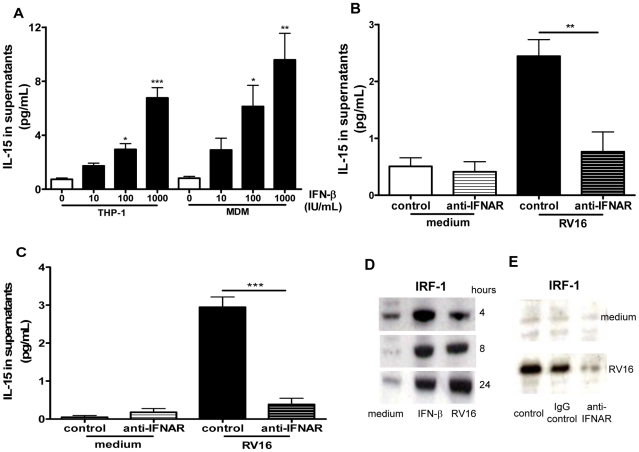
IFN-β induces IL-15 in macrophages and rhinovirus induction is via IFN-αβ receptor signalling.(A) THP-1-derived macrophages (THP-1) or monocyte-derived macrophages were stimulated with diluent control (0), or recombinant IFN-β at concentrations of 10, 100 and 1000 IU/mL, supernatants harvested at 72 hours and IL-15 quantified by ELISA. Means and SEM from at least three independent experiments (performed in triplicate) are shown. * P<0.05, ** P<0.01 and *** P<0.001, compared with diluent control. (B) THP-1-derived macrophages and (C) monocyte-derived macrophages were pre-treated for 1 hour with IFN-αβ receptor blocking antibody (anti-IFNAR) or isotype control (both at 5 µg/mL), the same concentration of antibody was added to the medium after infection with RV16, supernatants were harvested at 24 hours (C) and 72 hours (B) and IL-15 quantified by ELISA. Means and SEM from at least four independent experiments (performed in triplicate) are shown. ** P<0.01 and *** P<0.001 compared with isotype control. (D) Lysates of THP-1-derived macrophages incubated with medium alone (medium), or stimulated with IFN-β (IFN-β) at 1000 IU/mL or RV16 (RV16) were analysed for the presence of IRF-1 by Western blot at 4, 8 and 24 hours. A representative image of three independent experiments with similar results is shown. (E) Monocyte-derived macrophages treated as in (C) were lysed after 24 hours and analysed for IRF-1 by Western blot. RV16 induction of IRF-1 protein over medium control (medium) was clearly inhibited by prevention of αβ IFN signalling with an IFN-αβ receptor blocking antibody (anti-IFNAR), but not by isotype control (IgG control), or diluent alone (control). A representative image of three independent experiments with similar results is shown.